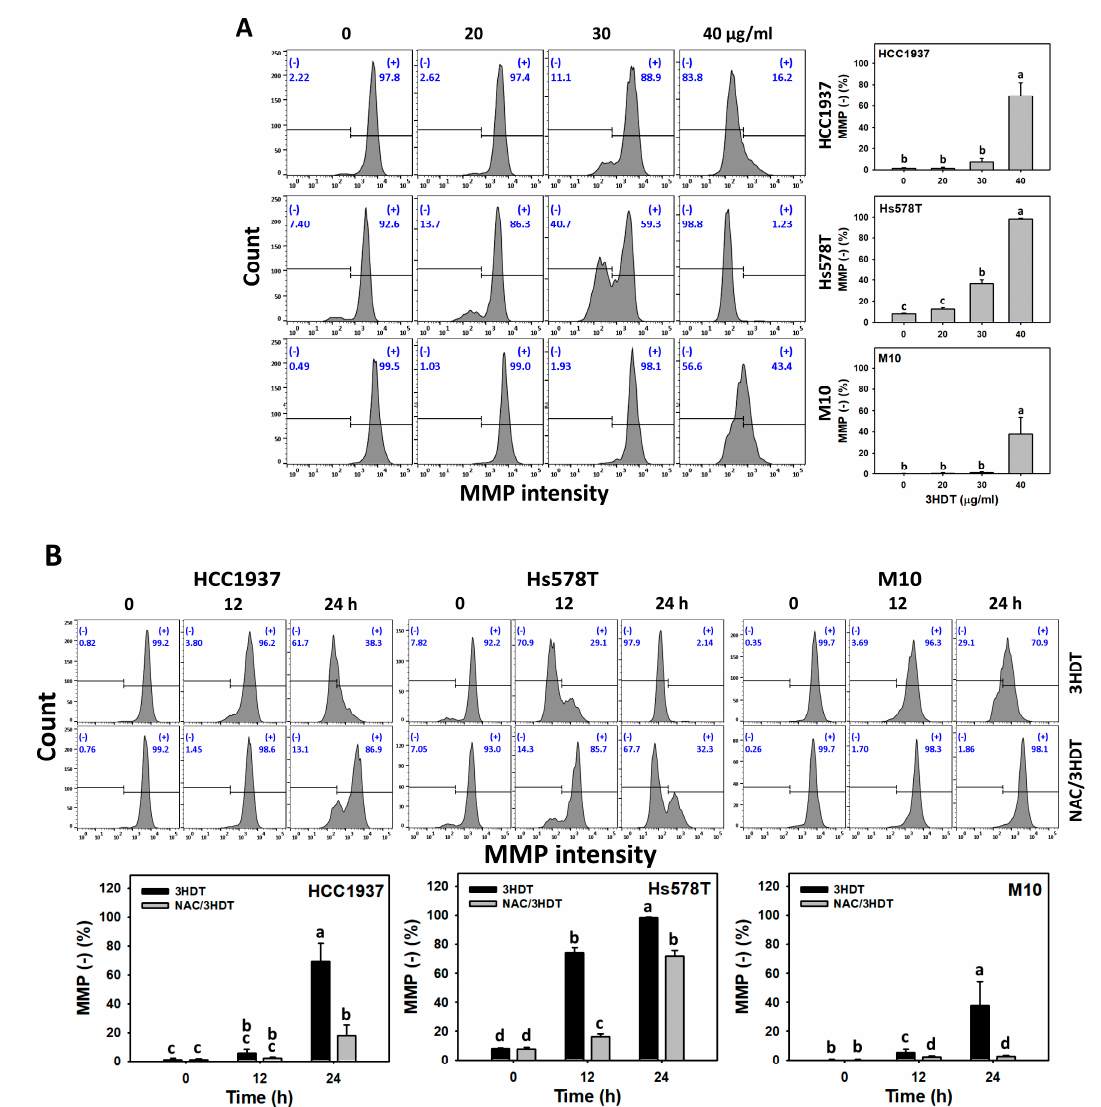
Figure 6. MMP status of 3HDT treatment. ( A ) MMP flow cytometry assay of 3HDT for 24 h. ( B ) MMP flow cytometry assay of NAC/3HDT. 3HDT and NAC/3HDT indicate 12 or 24 h 3HDT treatment (40 μ g/mL) without and with NAC pretreatment, respectively. ( − ) is marked as MMP ( − ) that indicates the proportion with low MMP level, while (+) indicates the proportion with high MMP level. Data: mean ± SD ( n = 3). Treatments differ significantly for multiple comparisons when the lower-case letters are not overlapping ( p < 0.05).